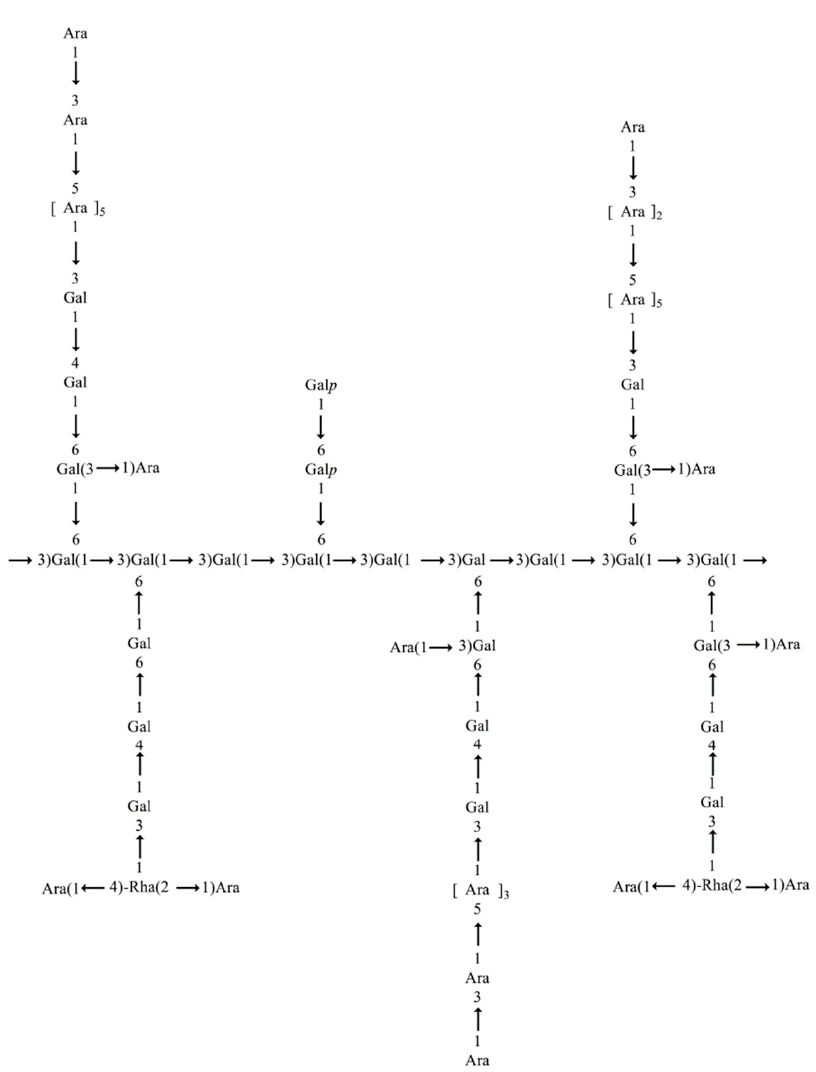
Figure 4. Schematic representation of the structural unit of LBLP5-A. Yang and his research team reported a high-purity homogeneous polysaccharide us- ing methylation analysis combined with FT-IR spectroscopy, GC-MS, and NMR analysis ( 1 H NMR, 13 C NMR, and (2D) NMR) techniques, which confirmed that it was composed of a repeated unit of → 6)- β -Gal (1 → residues and branches composed of α -Ara, β -Gal, and α -Rha residues at position C-3(Figure 9) [8]. RG-I-type pectin was extracted and purified from L. ruthenicum Murr, and its structure was identified as neutral side-chains of arabi- nans and type II arabinogalactan, exhibiting putative structural characteristics (Figure 10) [47]that differed from those previously reported (Figure 11) [60]. Zhang and colleagues reported an acidic heteropolysaccharide, LFP-1, composed of abundant arabinogalactan, linear homogalacturonan acid, and rhamnogalacturonan acid . Its molecular weight is 1.78 × 10 4 kDa. According to HPGPC assay, it is composed of Rha, Ara, Xyl, Man, Glc, Gal, GlcA, and GalA in a molar ratio of 3.68: 34.88: 2.46:1.03:6.89:37.64:0.73:12.67. GC-MS and NMR data showed that its arabinogalactan is composed of a characteristic → 3)- β -Gal (1 → main chain and high content of crosslinked → 6)- β -Gal (1 → side chains substituted by branched α -Ara elements. The homogalacturonan linear fragments composed of the re- petitive moiety of → 4) GalA (1 → residues alternated with short segments of rhamnogalac- turonans; model structures are shown to illustrate the main structural molecules rather than explicit structures (Figure 12) [61]. An acidic polysaccharide extracted from Lycium barbarum has obvious differences in its monosaccharide composition. However, most of